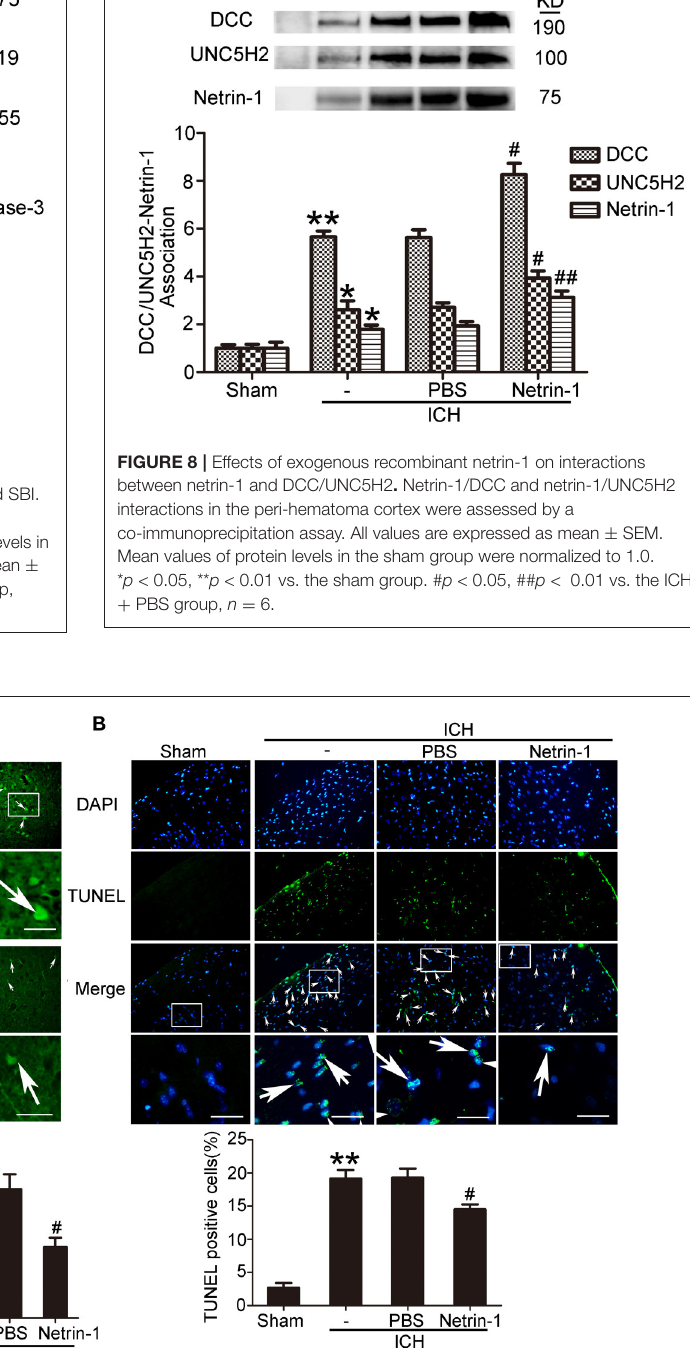
Frontiers in Cellular Neuroscience |